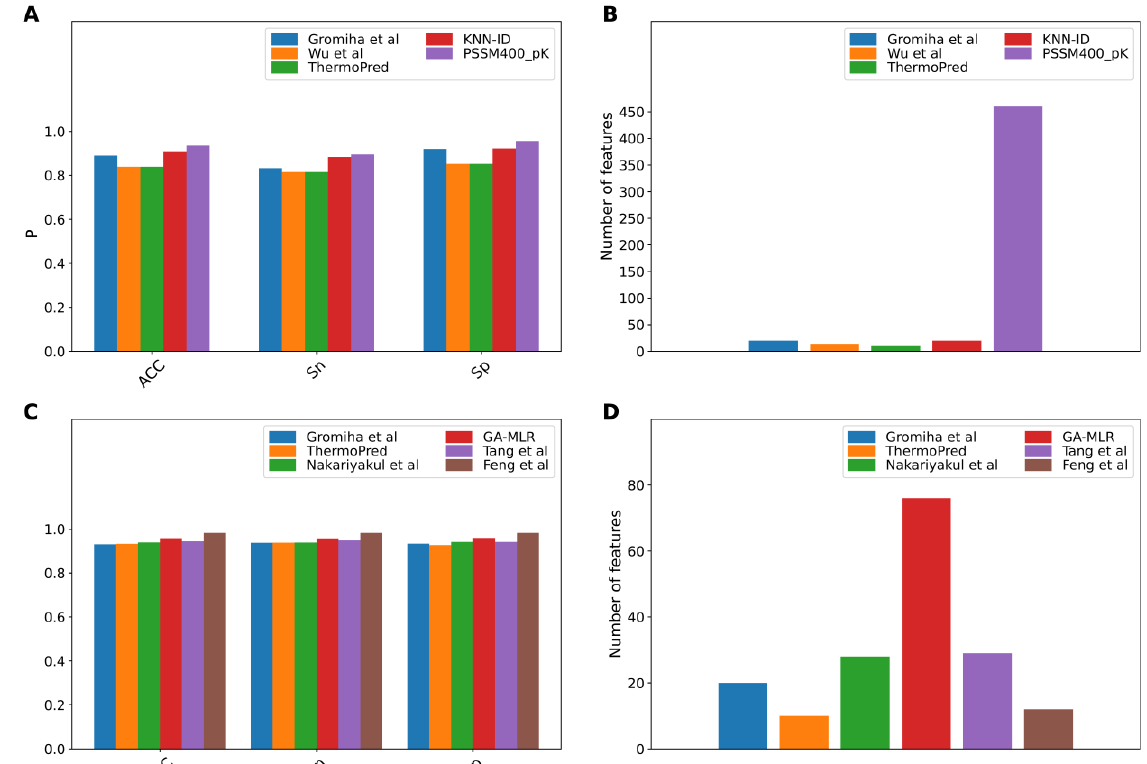
Figure 2: Performance comparison of existing TPP predictors on the Gromiha2007 ( A-B ) and Lin2011 ( C-D ) datasets. ( A, C ) represent the performance in terms of ACC, Sn and Sp. ( B, D ) represent the feature number used in existing TPP